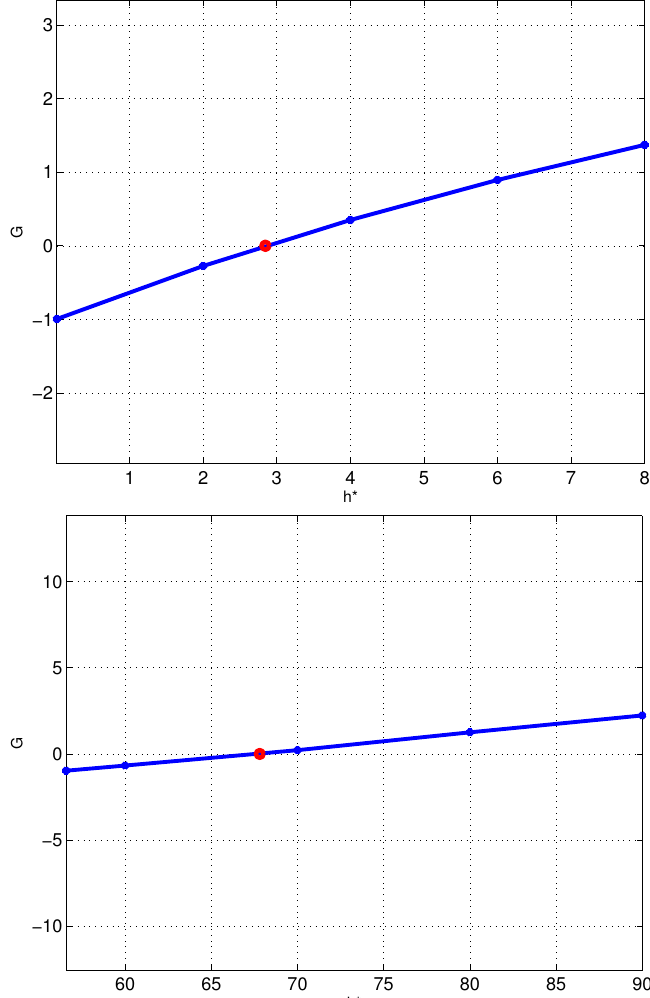
Figure 4. Two cases of the Γ ( h ∗ ) function: top and bottom frames are related to normal and reverse flow solutions, respectively.